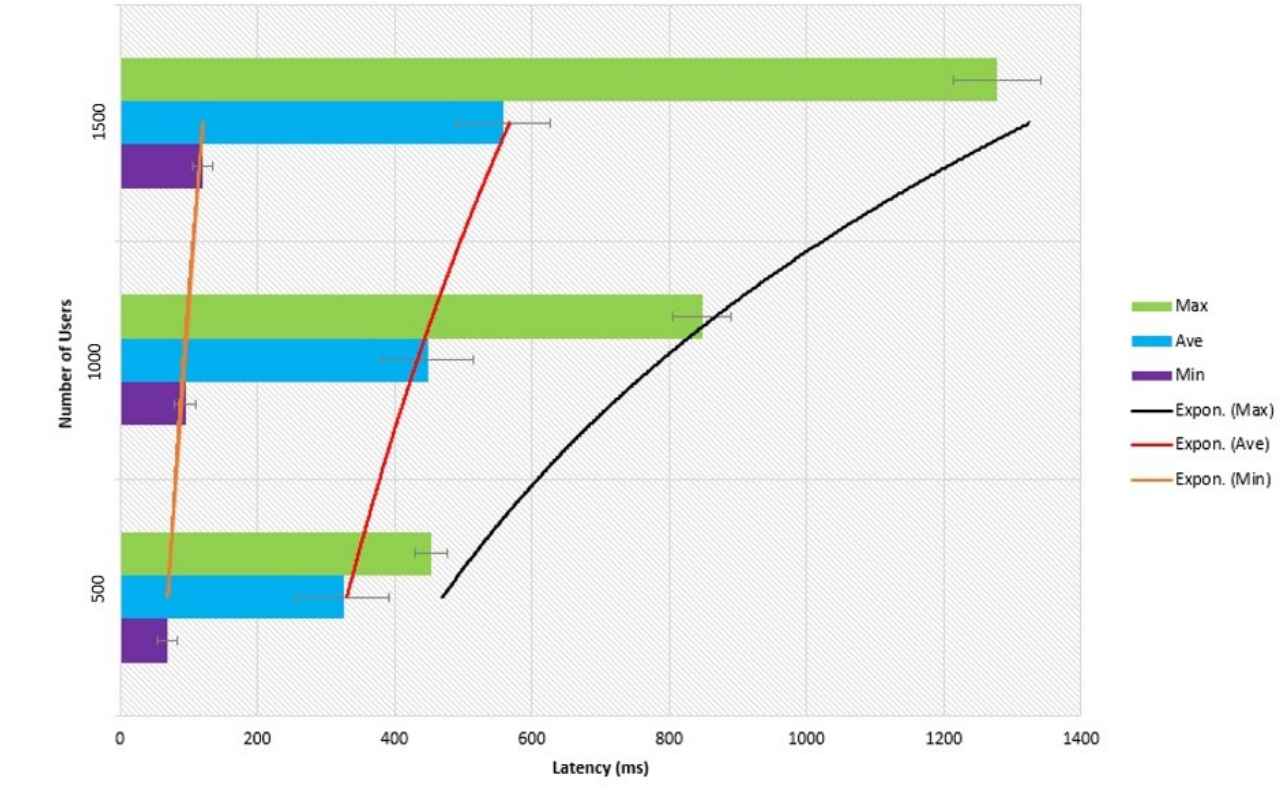
Figure 10. Latency of query